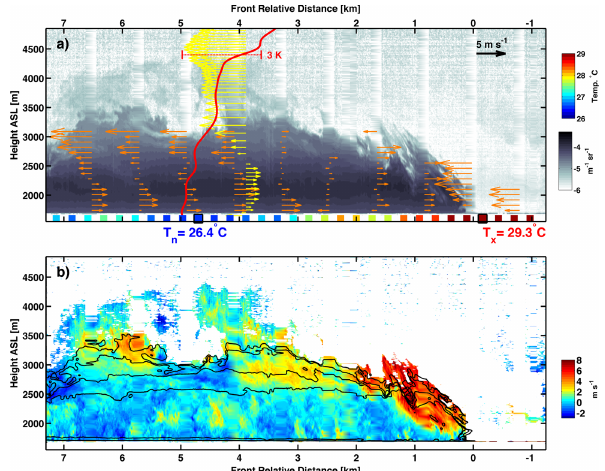
Figure 4. The anatomy of the smoke-induced density current dur- ing intercept D at 14:02PDT. (a) Logarithmic attenuated backscat- ter (m − 1 sr − 1 ) overlaid with the lidar derived front-relative hori- zontal winds (orange), radiosonde front-relative winds (yellow), ra- diosonde potential temperature (red), and near-surface air temper- atures (shaded squares). The maximum ( T x ) and minimum ( T n ) temperatures are annotated. (b) lidar vertical velocity (shaded) and smoke backscatter (black contours at − 4, − 4.5, and − 5m − 1 sr − 1 )